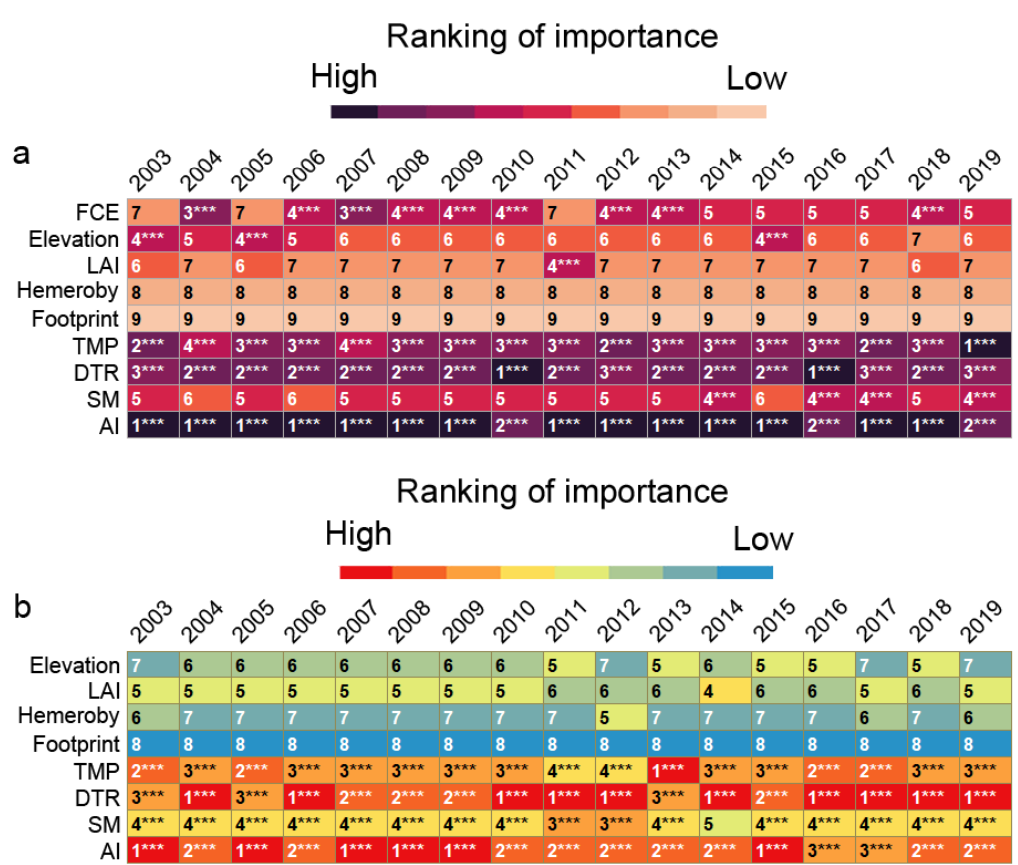
Figure 3. Variable importance rank (IncNodePurity—increase in node purity) of PM 2.5 concentration ( a ) and FCE ( b ) from RF in NL in 17 years (average). The orange and blue bars represent the significant ( α < 0.05) importance of the variable, while the black bar represents the insignificant importance of the variable. Var explained reflects the overall explanatory rate of predicted variables to PM 2.5 and FCE related to variance; p -value is the significance of the RF model based on complete variables. ( c , d ) Local importance maps of the PM 2.5 concentration and FCE variables, respectively.